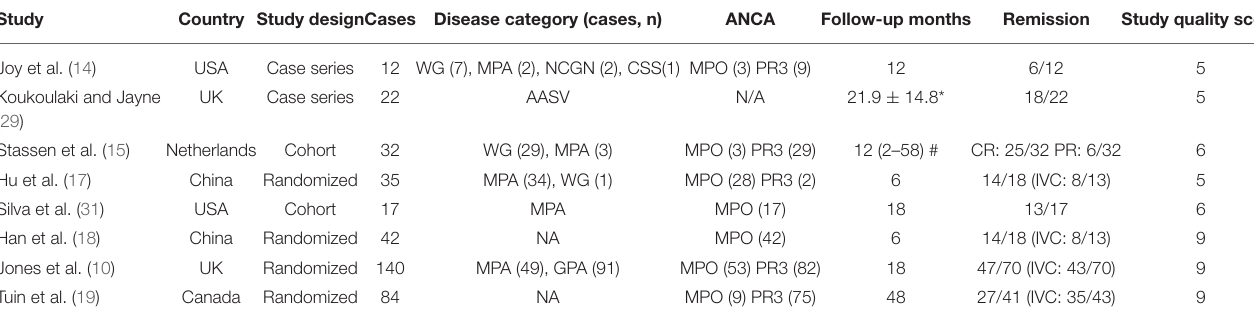
TABLE 1 | Basic characteristics of included